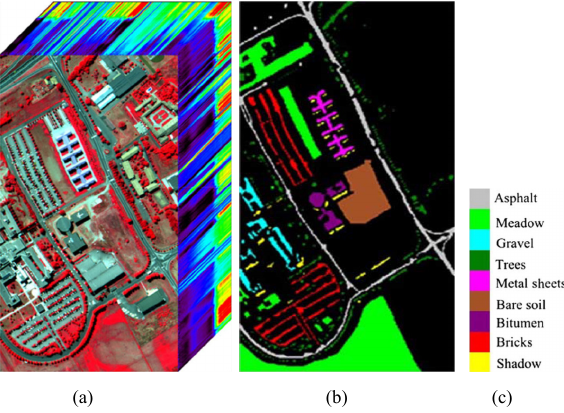
Fig. 2. Pavia University data set. (a) Original image produced by the mixture of three bands. (b) Ground truth with nine classes. (c) Map